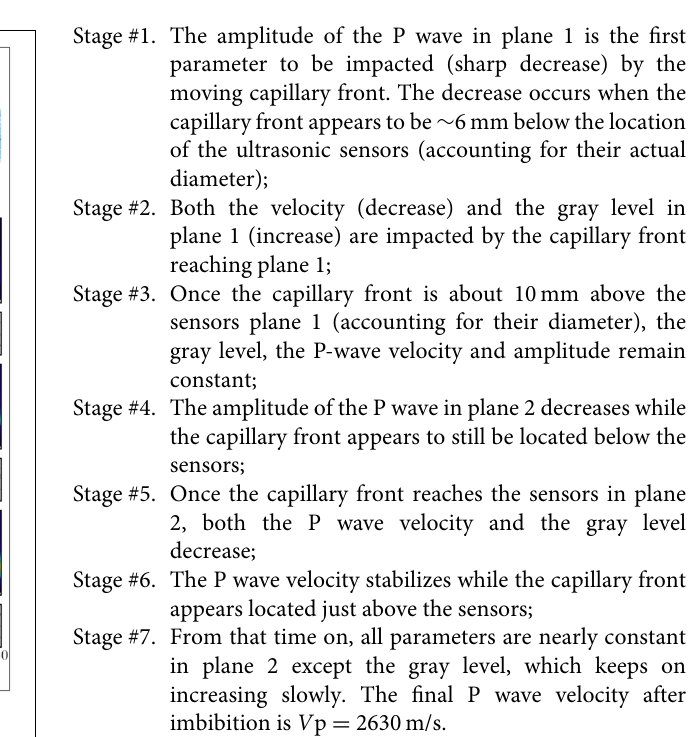
FIGURE 6 | Superimposition of transmitted signals during imbibition tests on Majella and Saint-Maximin samples (the first waveform is displayed in red and corresponds to the dry sample and the last one is displayed in dark blue) and spectrograms with corresponding waveforms at different stages (stage #1: beginning of the test, stage #2: arrival of the water front near the sensor plane, stage #3: end of the